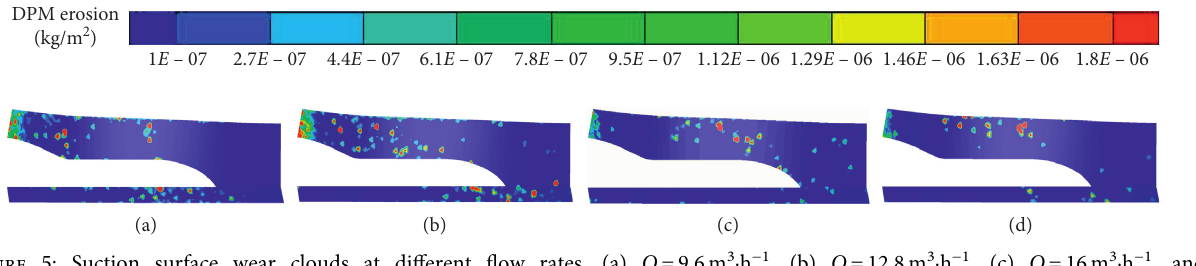
Figure 5: Suction surface wear clouds at different flow rates. (a) Q � 9.6m 3 · h − 1 , (b) Q � 12.8m 3 · h − 1 , (c) Q � 16m 3 · h − 1 , and (d) Q � 19.2m 3 · h − 1 .